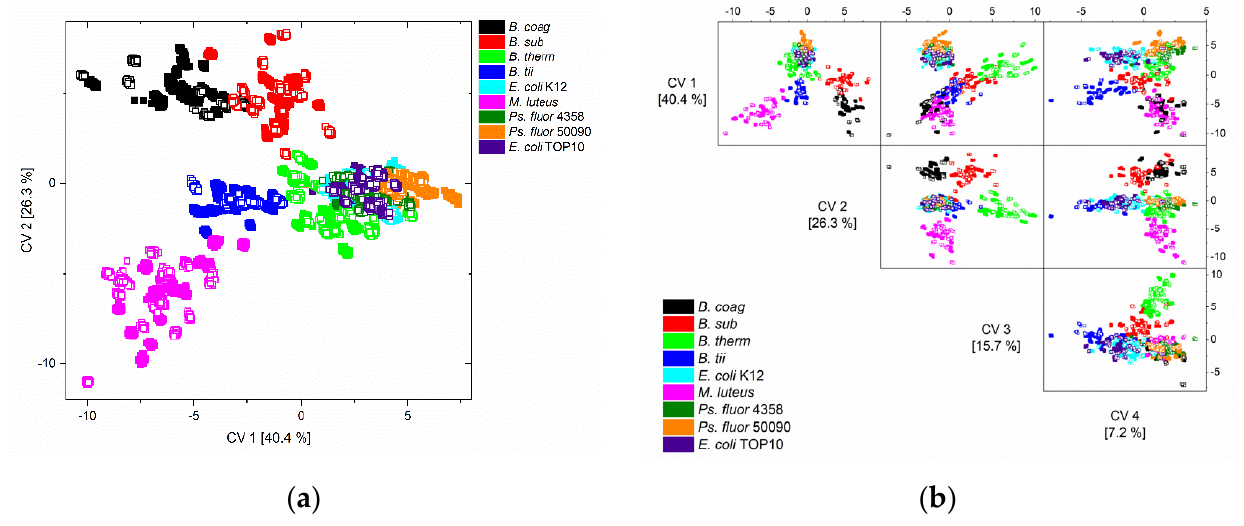
Figure 3. Scatter ( a ) and scatter matrix ( b ) plot of canonical variable one and two, and one to four of the QDA of the training data (solid squares) and the independent test data (unfilled squares) of all nine microorganisms and all nine conditions. M. luteus and all Bacillus spp. ( B. coag , B. sub , B. therm , B. tii ) could be separated